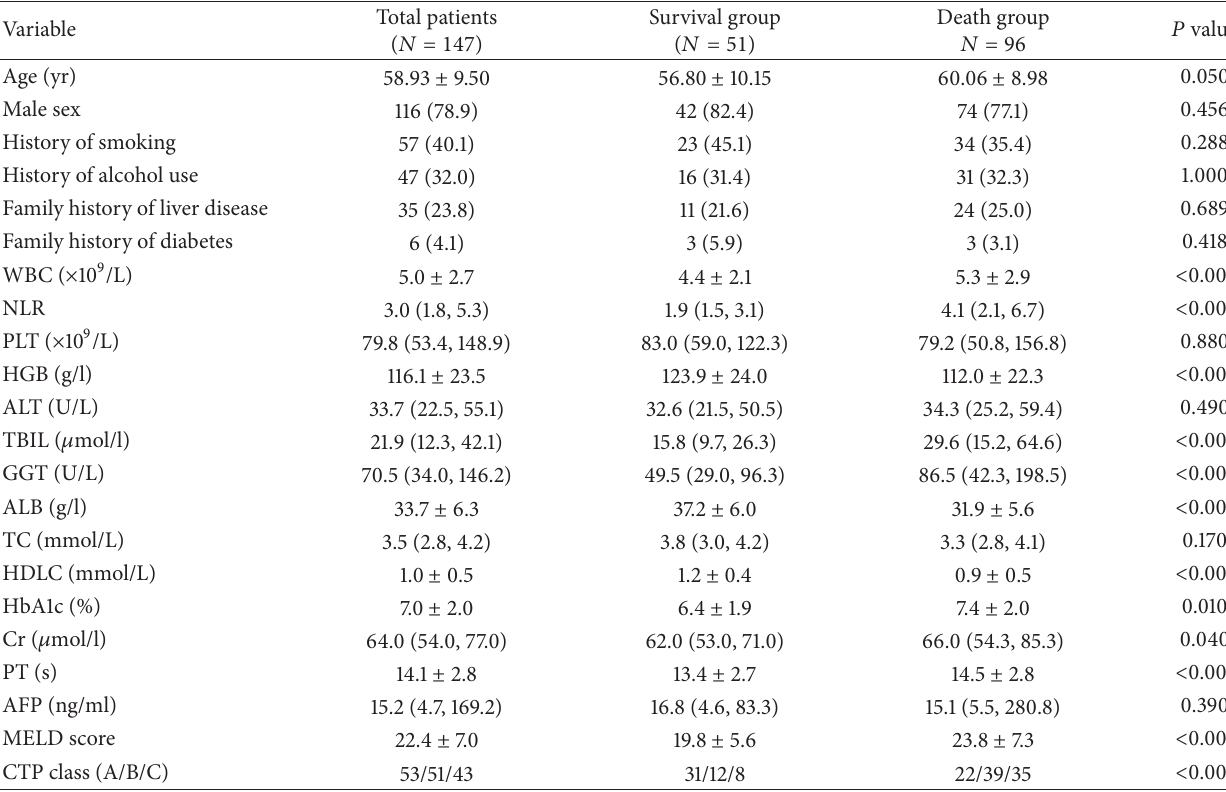
Table 1: Characteristics of